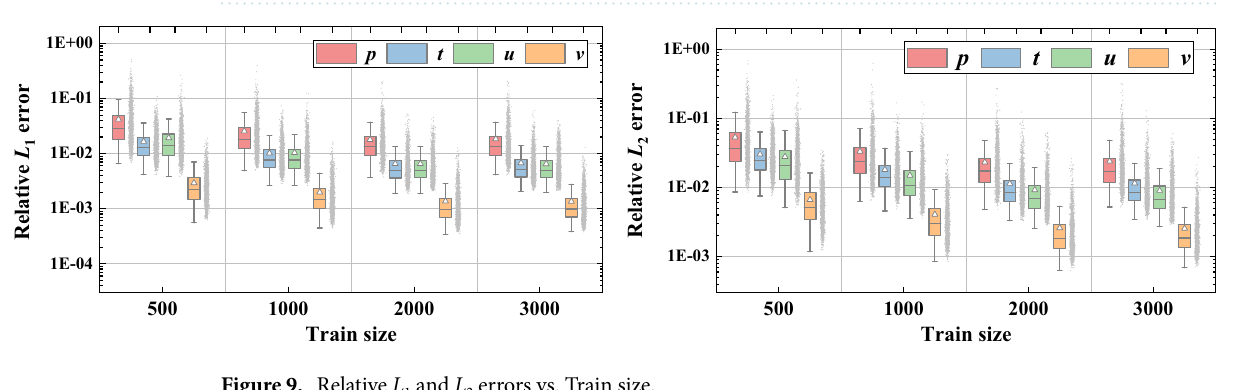
Figure 8. Comparison of prediction performance between different models.